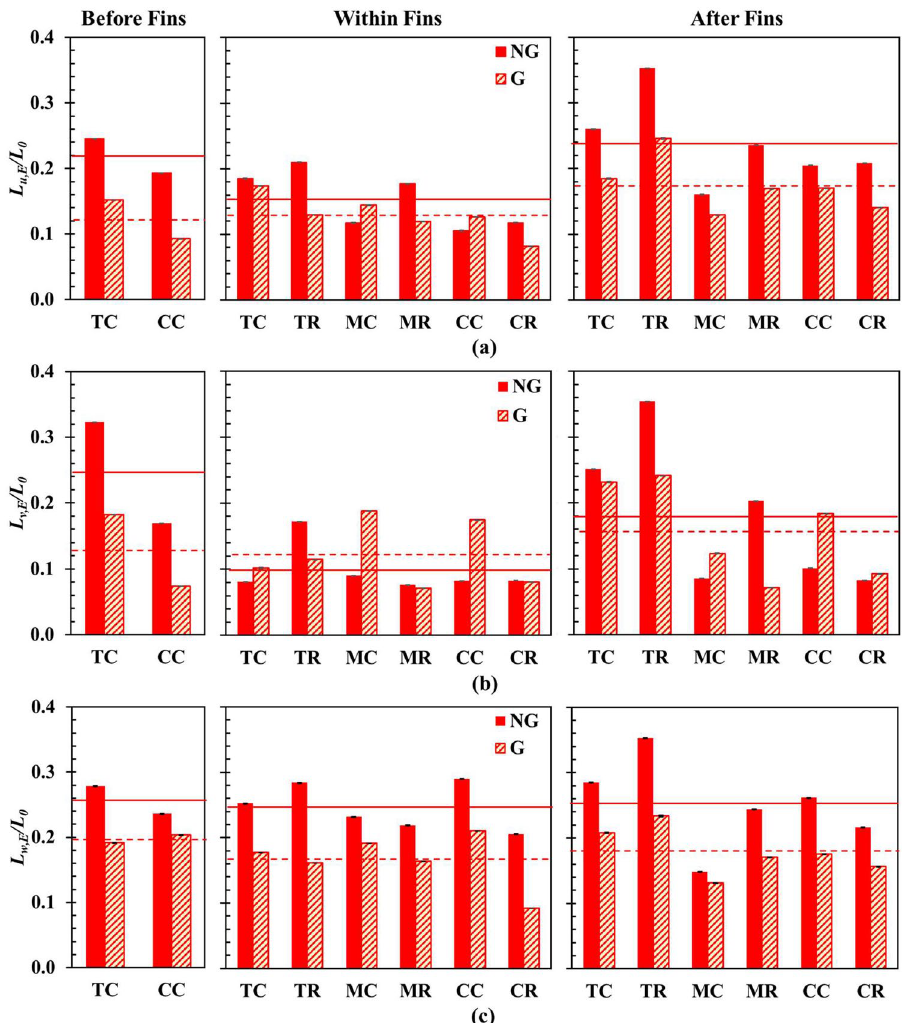
Figure 11. SPTV detected equivalent integral length scale, non-dimensionalized with L 0 of the ( a ) streamwise u , ( b ) spanwise v , and ( c ) cross-stream w fluctuating velocity